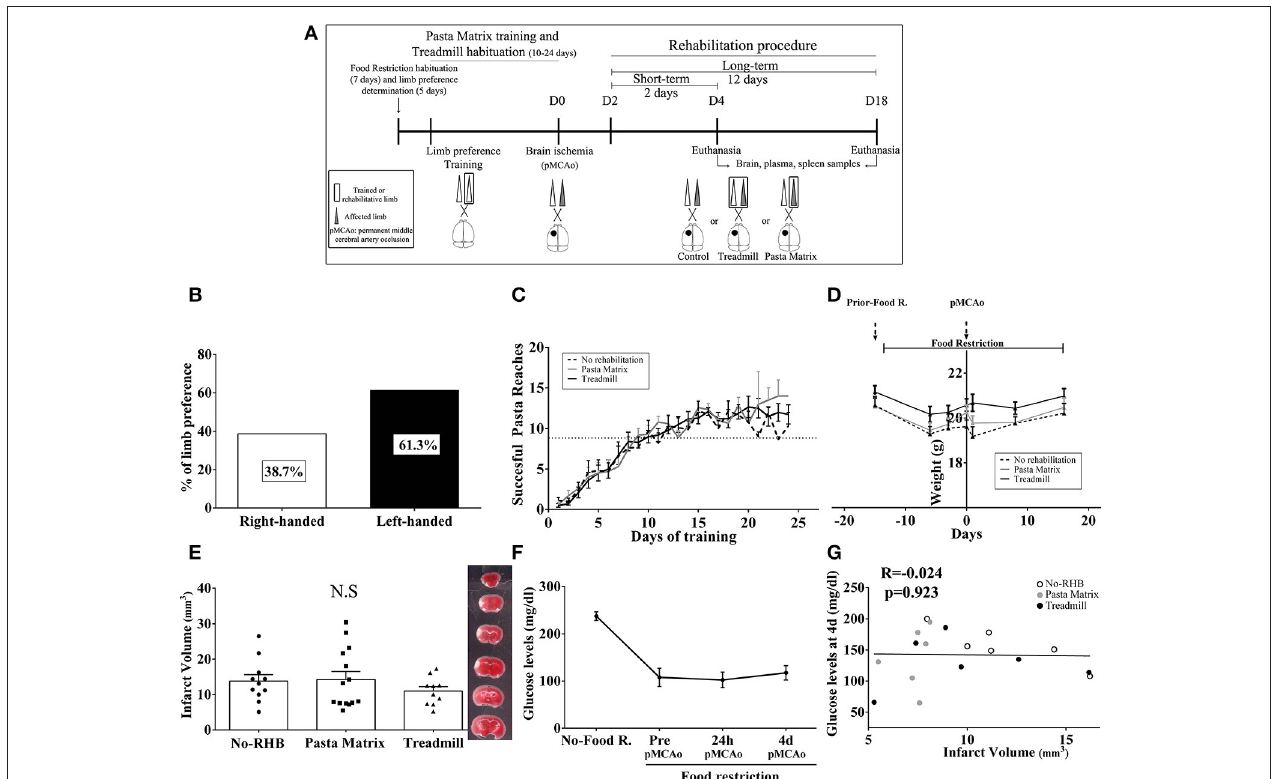
FIGURE 5 | (A) Mouse rehabilitation model. (B) Graph showing limb laterality preference in our cohort of mice ( n = 74). (C) Graph representing the temporal profile of pasta matrix reaching-task training in n = 10 animals/group. (D) Body-weight graph during the entire procedure in n = 10 animals/group. (E) Bar graphs showing the mean infarct volume during the short-term phase of rehabilitation with no significant differences between groups ( n = 10–14). (F) The glucose monitoring graph during acute cerebral ischemia (F) . (G) Scatterplot showing no association between infarct volume and glucose levels during the short-term phase of rehabilitation (4 days pMCAo, n = 6/group). Data are represented as percentage, mean ± SEM, or single values in the scatter plot. NS, Non-significant; RHB, rehabilitation; pMCAo, permanent middle cerebral artery occlusion; R, restriction; d,